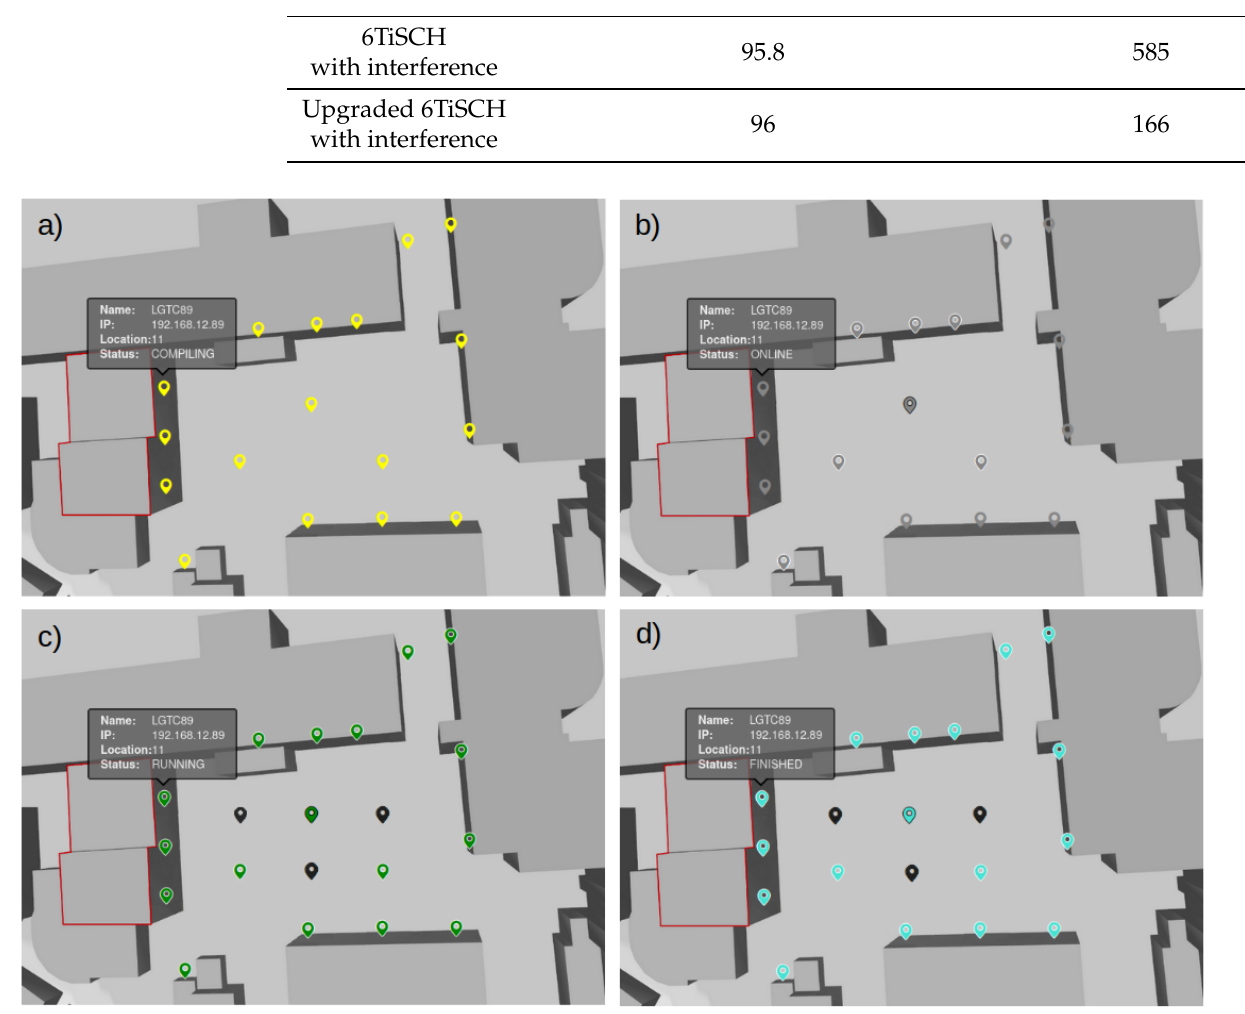
Figure 6. Status of nodes in LOG-a-TEC in experiment run-time: ( a ) code deployment was successful, ( b ) 6TiSCH network joining process, ( c ) nodes are running the experiment ( d ) experiment has come to the